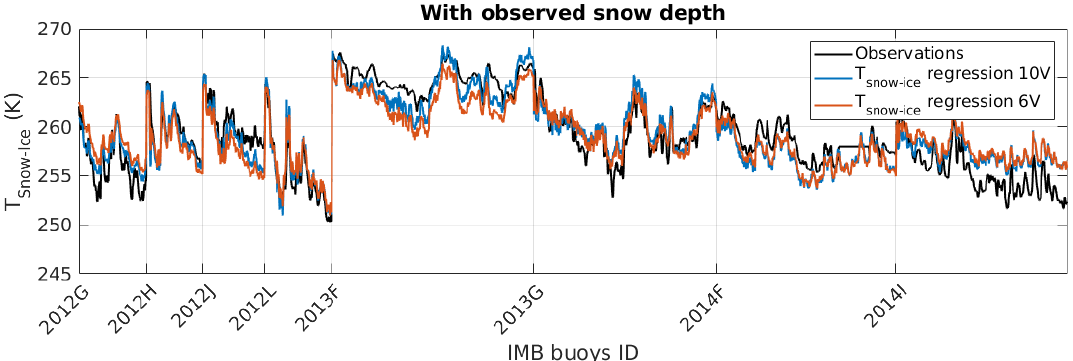
Figure 8. Time series of the comparisons between T Snow − Ice observations from IMBs (black line), and T Snow − Ice regressions with TBs at 10V (blue line) and at 6V (red line). The snow depth used in Eqs. (5) and (6) is the snow depth observed by the IMB sounder. The beginning of the measurements with a new IMB is indicated on the x axis.